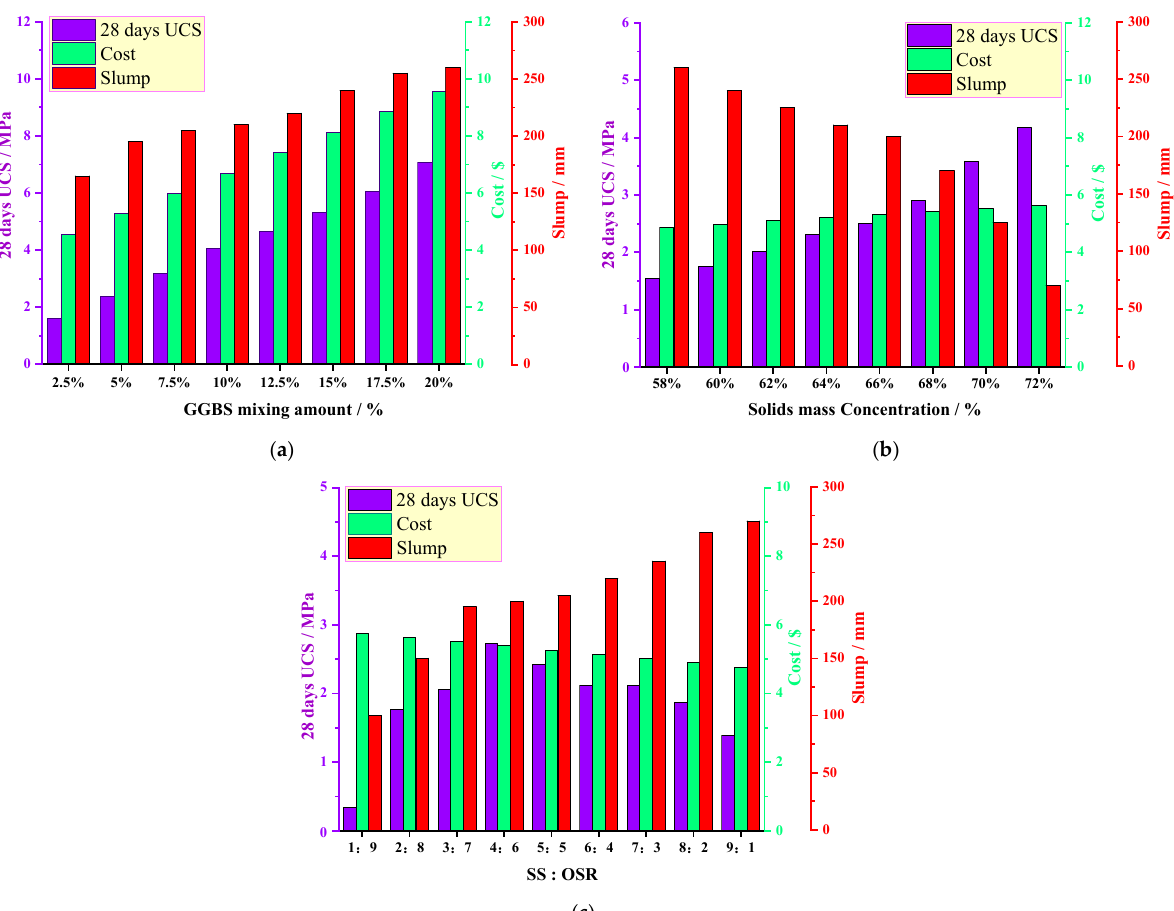
Figure 5. Single-factor effect of the ( a ) GGBS mixing amount; ( b ) solid mass concentration; and ( c ) SS to OSR mass ratio. When the mass ratio of SS to OSR was fixed at 1:1 and the GGBS mixing amount was 5%, the solid mass concentration was adjusted, and the effects of the solid mass concentration on the UCS, slump and cost of the COSGB were obtained, as shown in Figure 5b. Figure 5b shows that the 28 days UCS of the COSGB increases with increasing solid mass concentration. Additionally, the cost factor is relatively minimally influenced Table 4. Box–Behnken (BBD) experimental design.